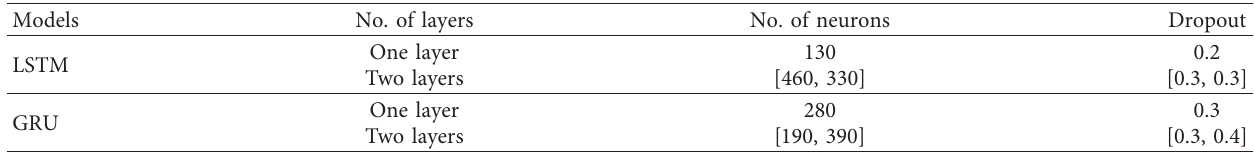
Figure 5: Comparison between real death cases and the predicted death cases for GRU (Egypt). Table 6: The best value parameters of DL for the confirmed cases in Saudi Arabia.